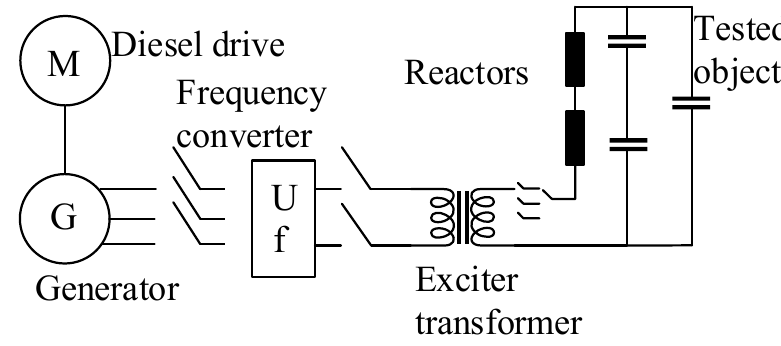
Figure 5. Resonant testing system schematic diagram.